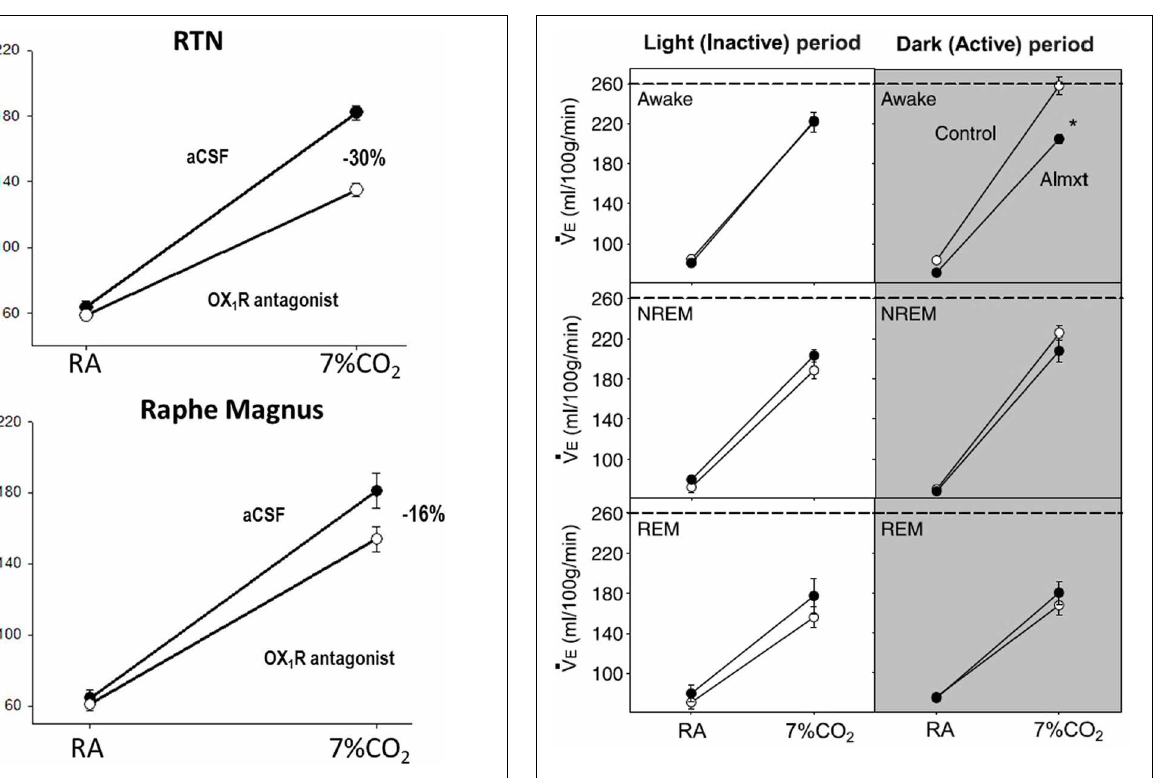
FIGURE 10 | Focal application of an OX 1 R antagonist in the RTN and the medullary raphe magnus decreases the CO 2 chemoreflex. Inhibition of OX 1 R in the region of RTN ( unilateral, A) or raphe magnus (B) by an OX 1 R antagonist (SB334867) significantly decreased the CO 2 chemoreflex by 30 or 16% respectively in wakefulness. (Figure adapted with permission from Dias et al., 2009 and Dias et al., 2010).